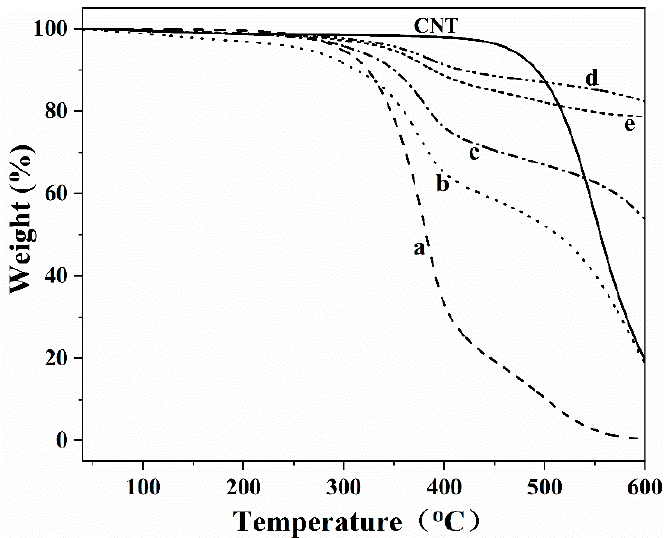
Figure 5. The TGA curves: ( a ) fluorine resin; the coatings with same CNTs of 30 wt. % and different SiO 2 nanoparticles contents: ( b ) 0 wt. %; ( c )15 wt. %; ( d ) 45 wt. %; ( e ) the coatings with SiO 2 nanoparticles of 75 wt. %.